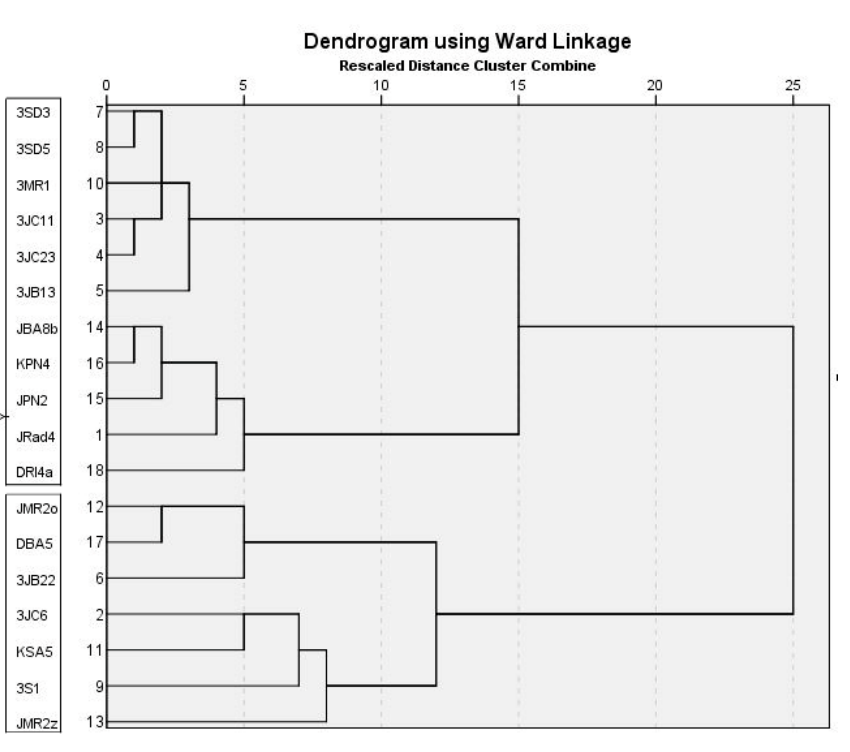
Figure 4. Dendogram showing the grouping of Penicillium expansum isolates based on colony diameter on different media (PDA, MEA, CYA, and YES), reverse on PDA and MEA (cream or yellow), and CYA reverse characteristics, using Ward’s model with Euclidian Distance interval. P. expansum isolates within a clade are indicated in black boxes.